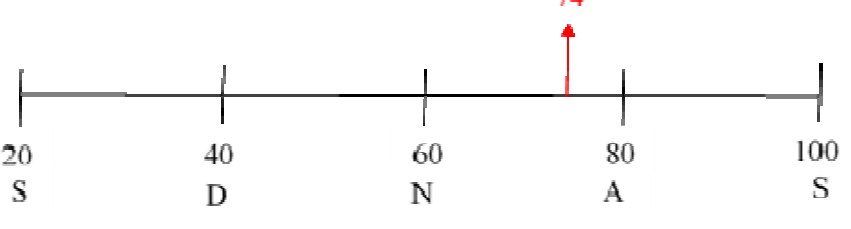
Figure 6: The score of Likert-scale questionnaire answered by the low- proficiency